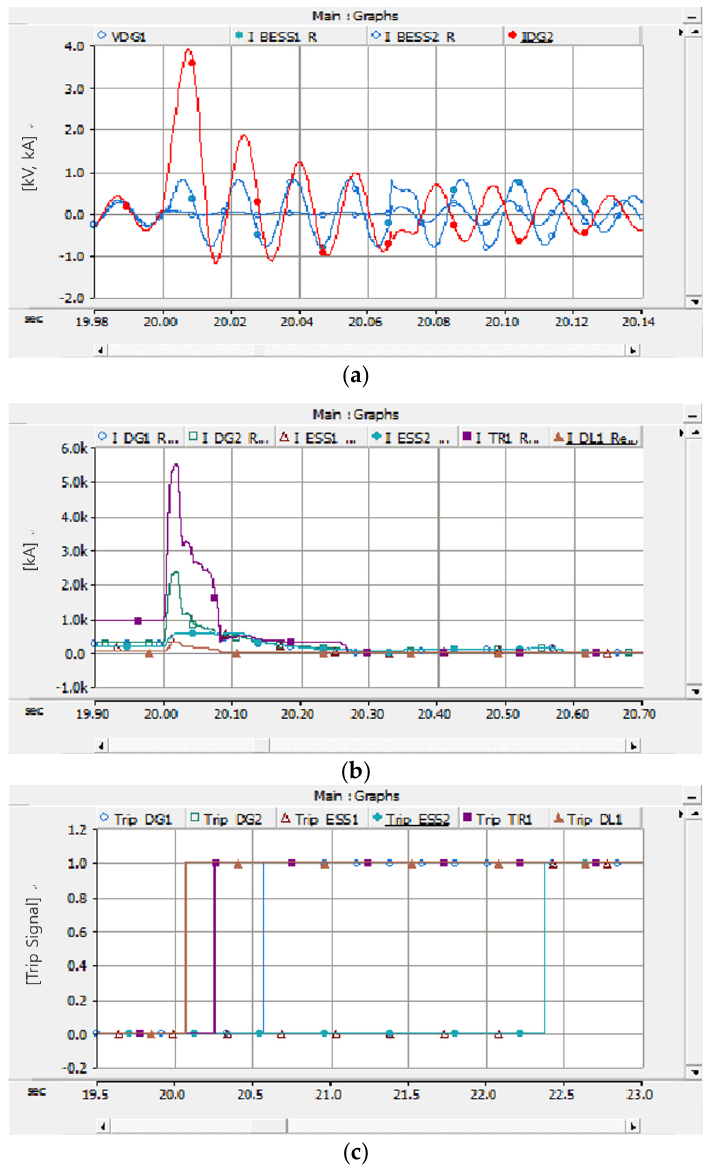
Figure 12. Simulation results of Case #4: ( a ) voltage and current of diesel generators and ESSs; ( b ) current of each relay; ( c ) trip signal of each relay.